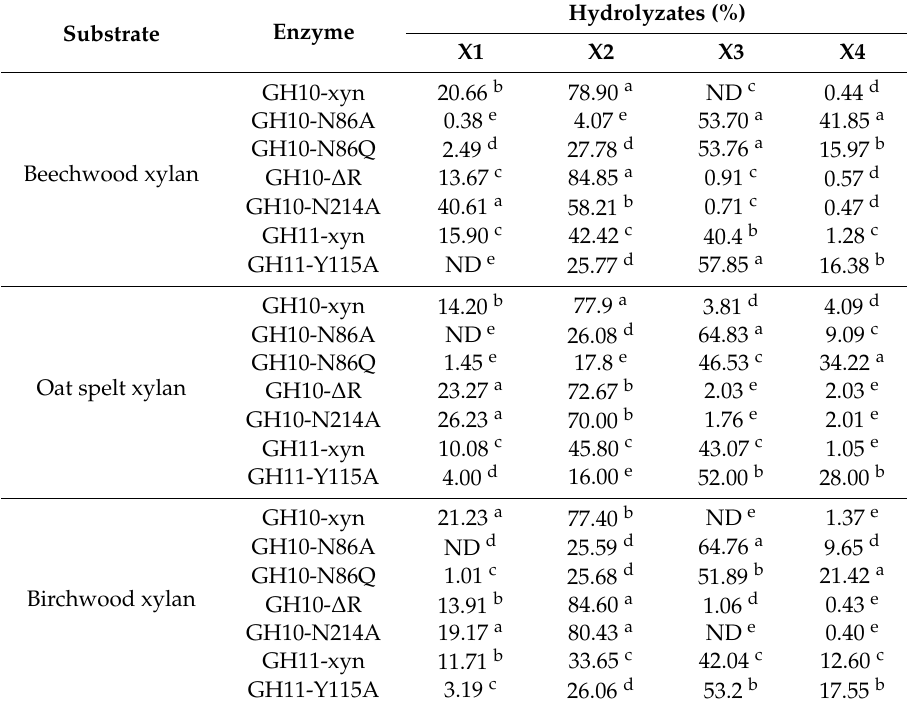
Table 3. Xylooligosaccharides composition in hydrolysis products with different polymeric substrates.